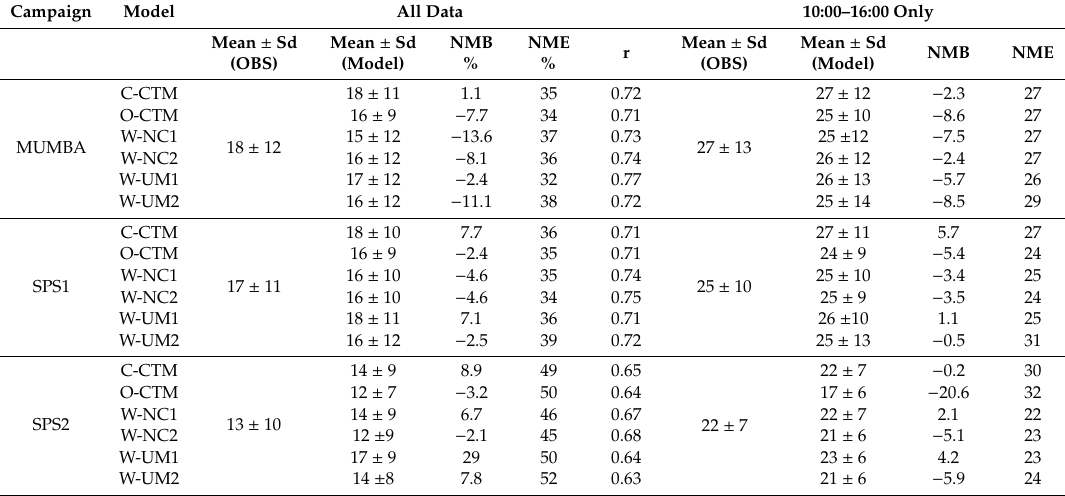
Table 2. Summary statistics for O 3 are listed for each model and each campaign including mean and standard deviation (Sd); normalized mean bias (NMB); normalized mean error (NME) and correlation coe ffi cient (r). Values for all the data are shown as well as for daytime data only (from 10:00 to 16:00